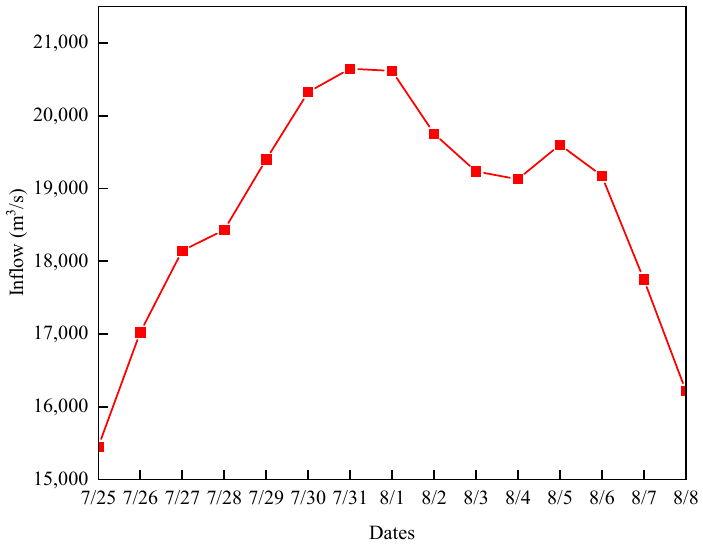
Figure 9. Maximum 15-day flood hydrograph of typical flood with a 100 return period in 1954.